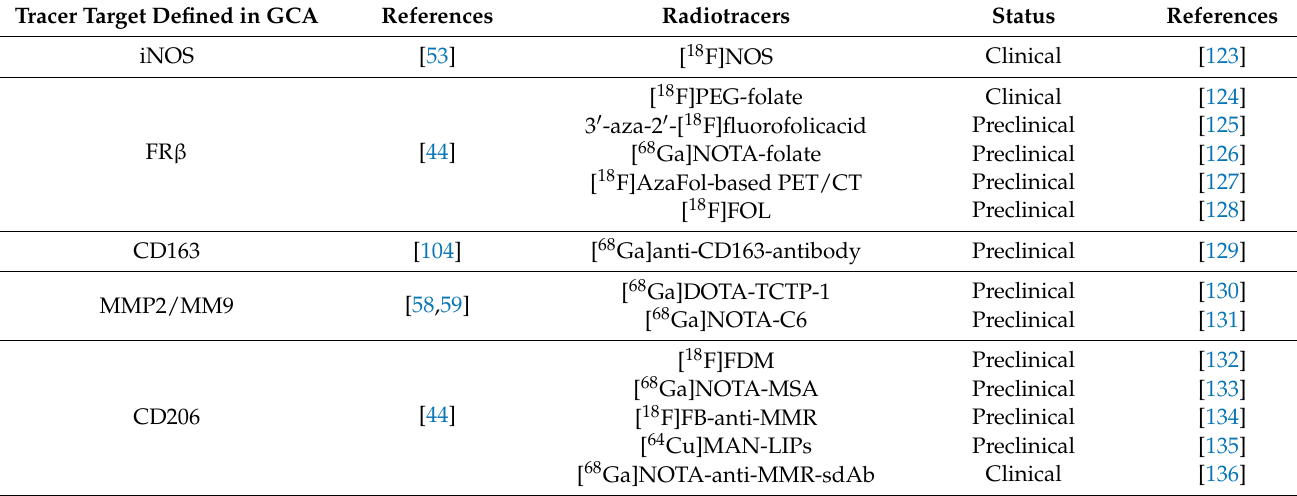
Table 1. Radiotracers targeting macrophage subsets in the GCA affected